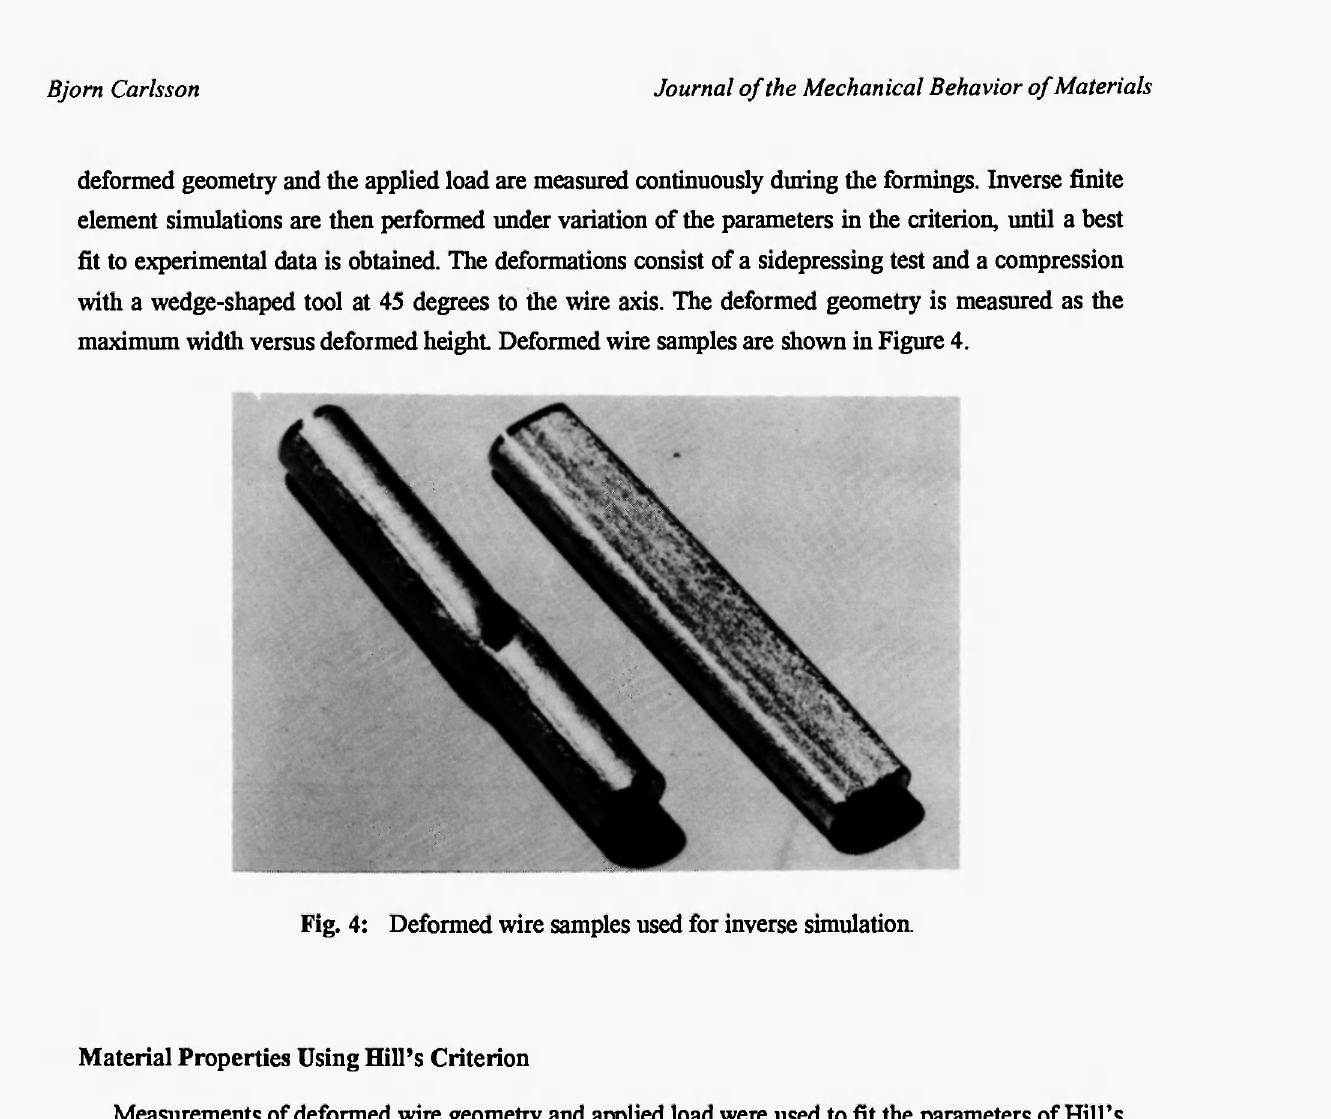
Fig. 4: Deformed wire samples used for inverse